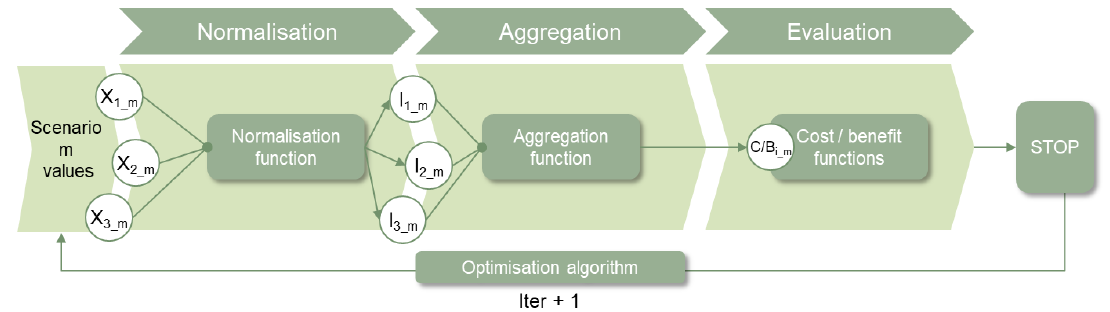
Figure 2. Scheme of the evaluation process.